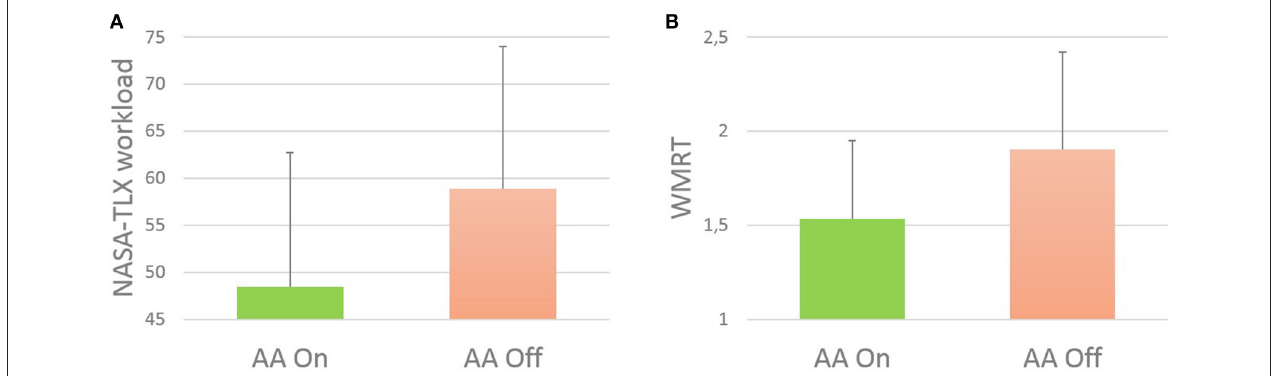
FIGURE 4 | (A) Vertical bars related to the subjective measure of the mental workload of the ATCOs, by using the NASA-TLX questionnaire. The results showed a not significant trend ( p = 0.068) between the two conditions (AA On and AA Off). (B) Vertical bars related to the Weighted Reaction Time index (WMRT), reflecting behavioral performances of operators during the two conditions (AA On and AA Off). The results showed a significant ( p = 0.045) increasing of task performances execution during AA On